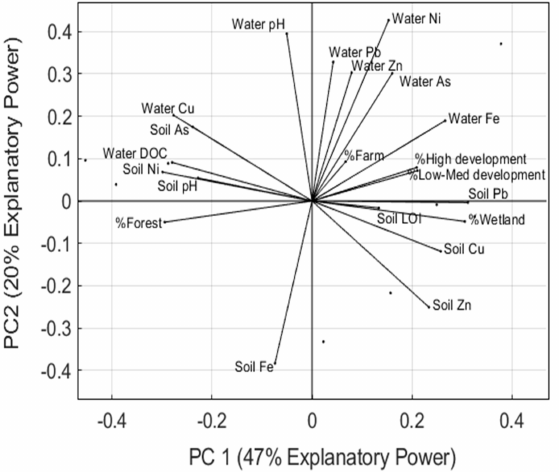
Figure 4. Principal component analysis of median soil trace element concentrations (abbreviated ‘soil’), median dissolved trace element normalized annual exports (abbreviated ‘water’), soil chemical properties (pH and LOI), water parameters (pH and DOC), and watershed land cover data for farms, forests, wetlands, low–medium development intensity, and high development intensity for each